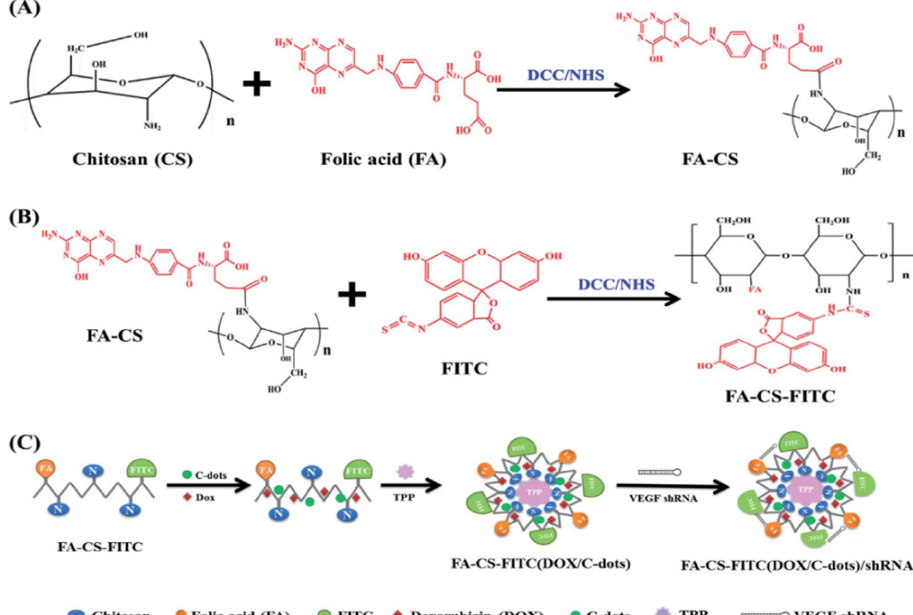
Figure 6. The illustration of the preparation and modification of FA–CS–FITC(DOX/C-dots)/VEGF shRNA nanoparticles [96]. Folic acid (FA) molecules were firstly conjugated to chitosan (CS) to form FA–CS ( A ), and then reacted with fluorescein isothiocyanate (FITC) to obtain FA–CS–FITC polymer complex ( B ). Doxorubicin (DOX) and carbon-quantum dots (C-dots) were doped, and VEGF shRNA was electrostatically absorbed on the nanoparticles ( C ). Copyright 2016, RSC.